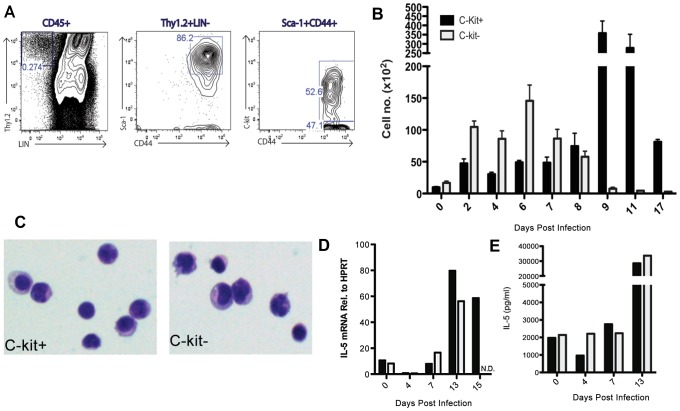
Group 2 innate lymphoid cells (ILC2) expand and are more potent producers of IL-5 during the resolution phase of infection.(A) Representative FACS plots identifying ILC2 in C57BL/6 mice. LIN antibody cocktail included: CD3, CD4, CD5, CD8, CD11b, Gr-1, CD19, B220, DX5 (or NK1.1) and TCRδ. (B) Absolute number of both c-kit+ and c-kit− ILC2 following infection. (C) c-kit+ and c-kit-ILC2 were FACS sorted from the lung at 7 d.p.i. and stained with hematoxylin and eosin. (D–E) c-kit+ and c-kit-ILC2 were FACS sorted from the lung at indicated times and (D) directly analyzed for IL-5 transcript or (E) cultured for three days in the presence PMA/ionomycin. (E) Supernatants were collected and IL-5 levels analyzed via ELISA. Data is representative of two experiments with ≥3 mice per group (A–C) or pooled from 15–20 mice (D–E). Bars = +/− SEM.